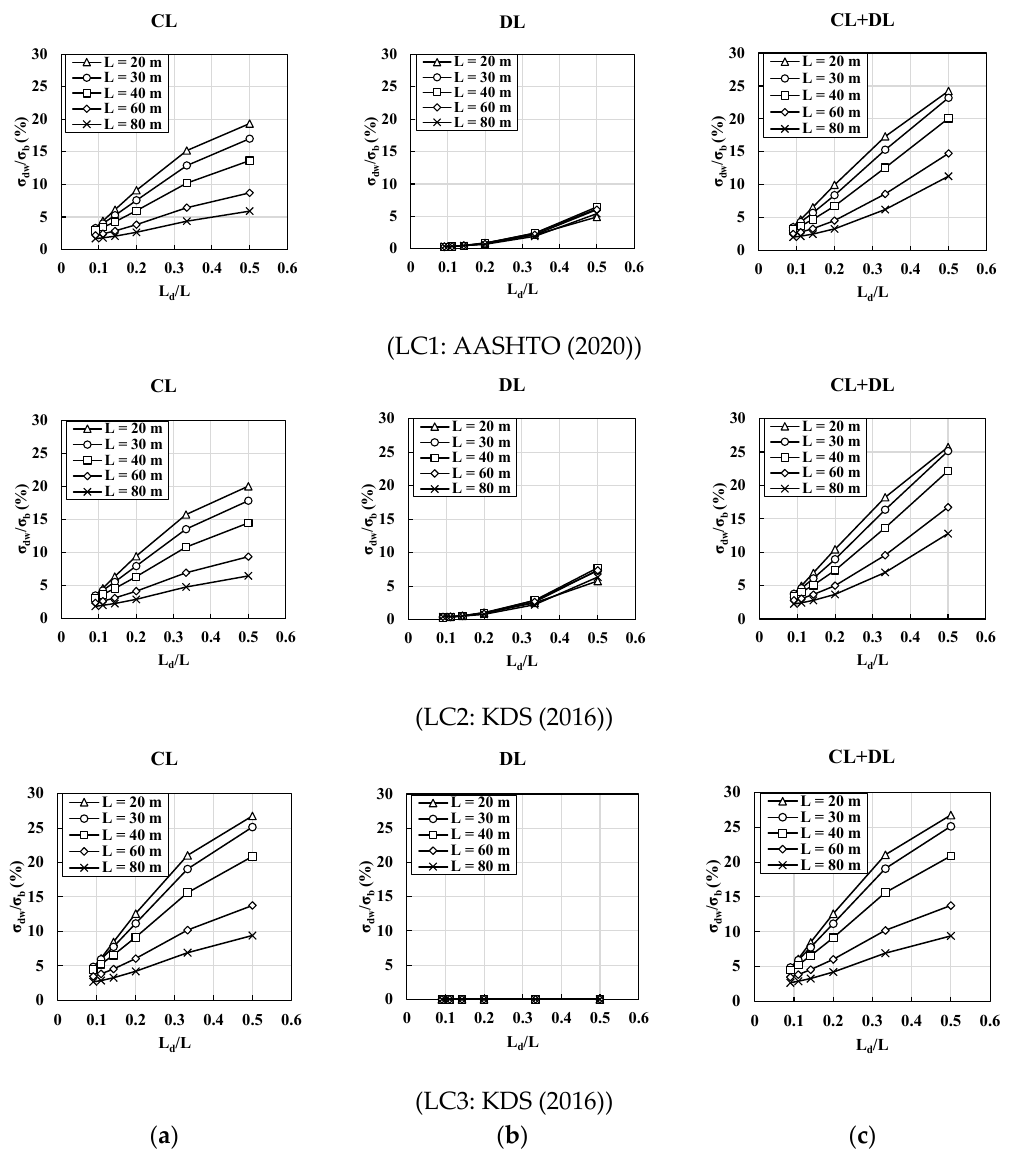
Figure 11. Variations in distortional warping normal stresses at H / B = 0.5 with the design load components. ( a ) Concentrated loads, ( b ) distributed loads, and ( c ) combined concentrated and distributed loads.